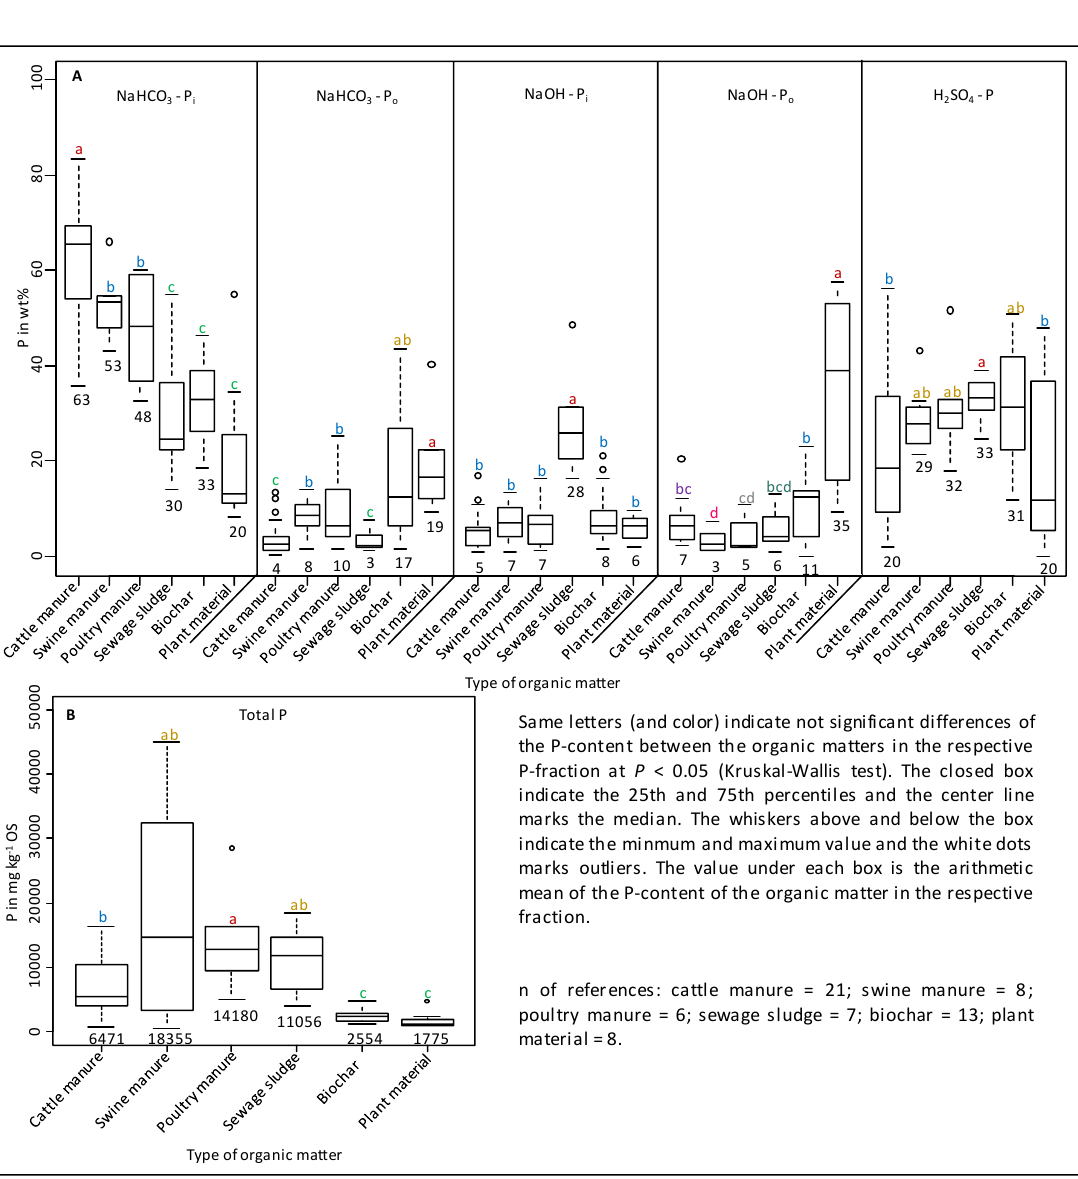
Figure 9. Box plot of the relative proportions of the P-fractions to the sum of fractions (NaHCO 3 -P i +